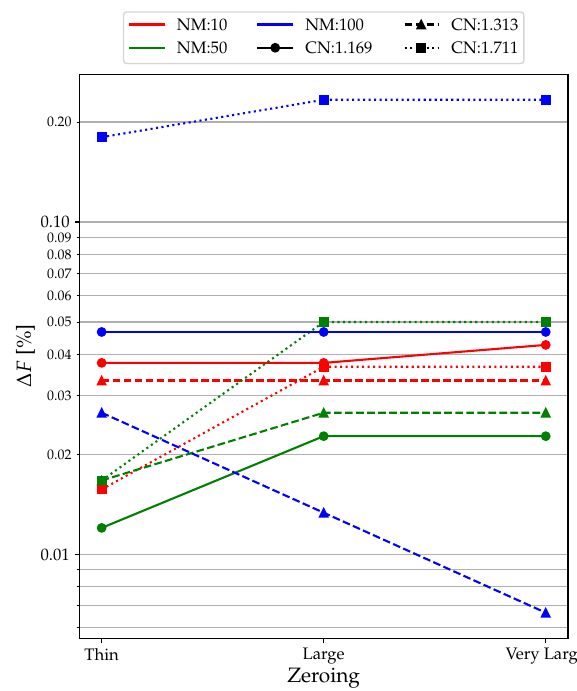
Figure 14. Zeroing analysis: ∆ F